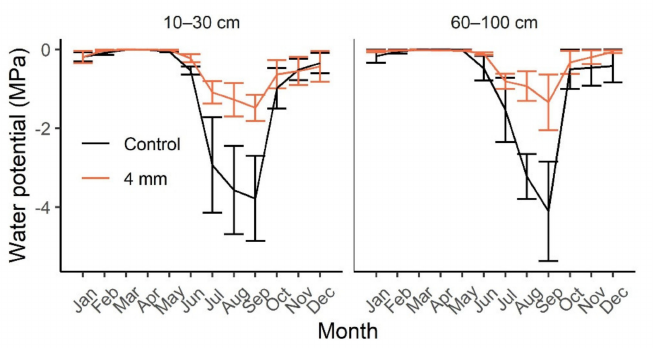
Figure 3. Shallow (10–30 cm; left panel) and deep (60–100 cm; right panel) soil water potential over time in a 4 mm event size treated plot and control plot. Water potential was measured separately with three sensors for each depth in each plot. Total annual precipitation was the same in both plots. Monthly values represent averages from hourly measurements from April 2016 to August 2019, the period during which precipitation treatments occurred. Error bars are standard errors based on the three sensors at each